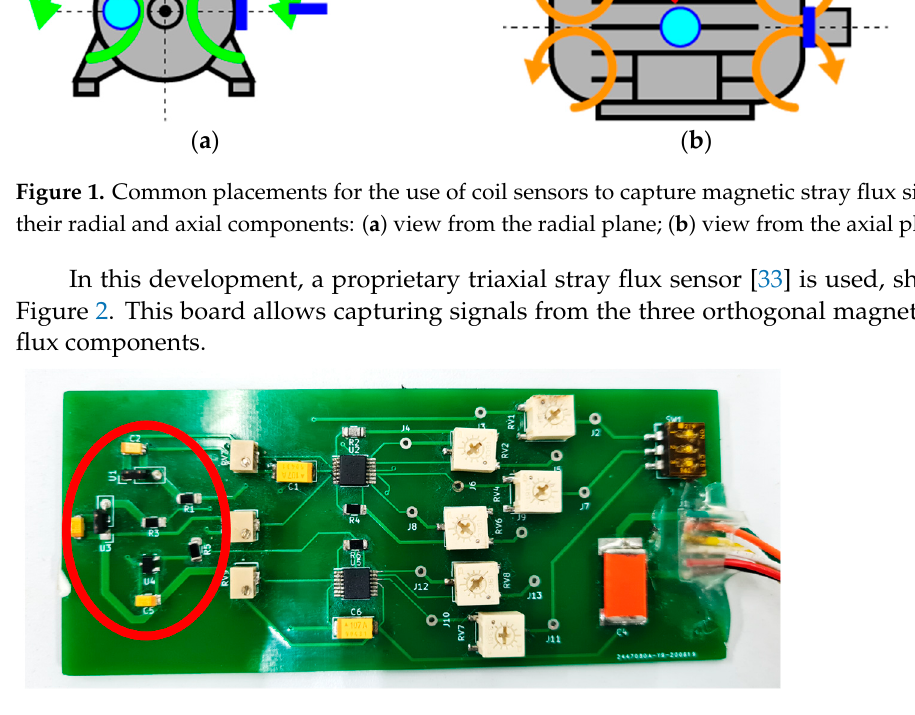
Figure 2. Proprietary triaxial stay flux sensor used to capture the CNC lathe’s spindle motor signals, with the primary sensing elements indicated with a red ellipse.